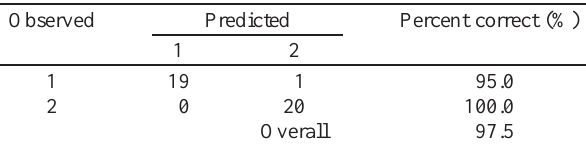
Table 1 Classification table for groups 1 and 2